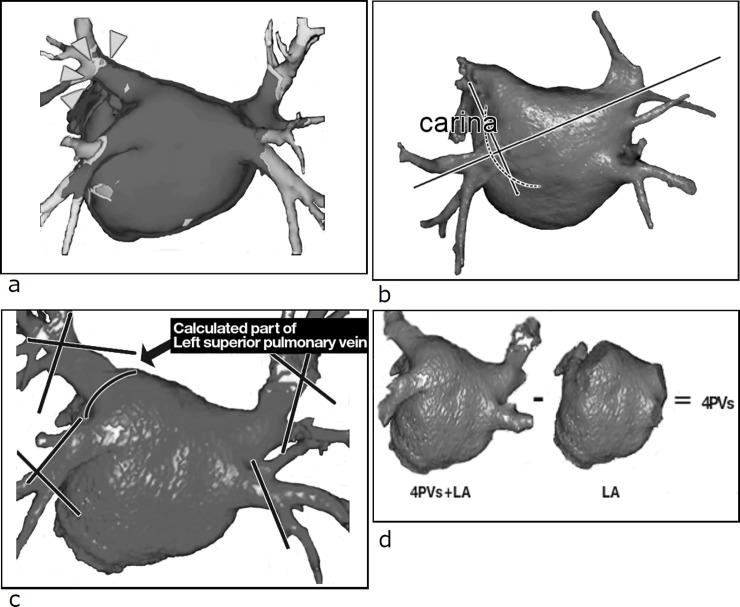
Three-dimensional volume-rendered reconstruction of the left atrium (LA) and pulmonary vein (PV).(a) Definition of the PV distal border as the first major branch in the simultaneously acquired voltage map (arrow head). (b) Definition of the PV―LA junction (dashed line). (c) Definition of the PV distal border and PV―LA junction. (d) Measurement of total PV volume and LA volume.